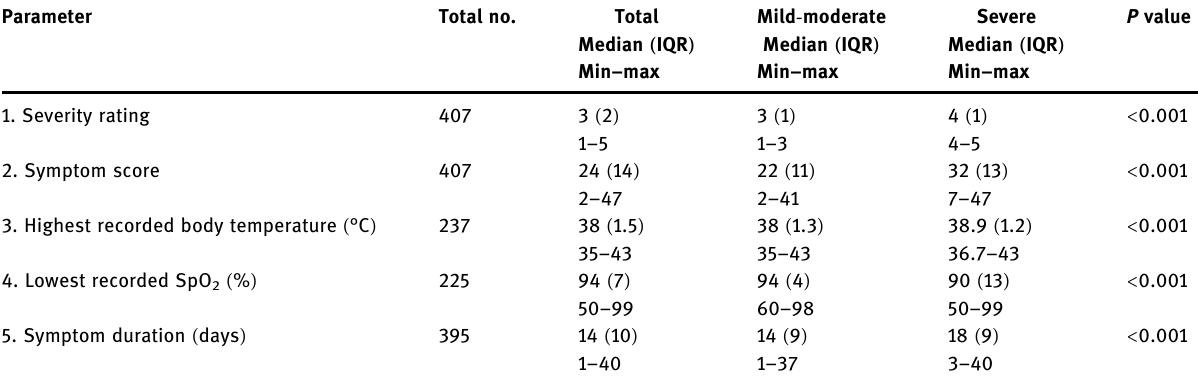
Table 2: Parameters of COVID - 19 severity I Parameter Total